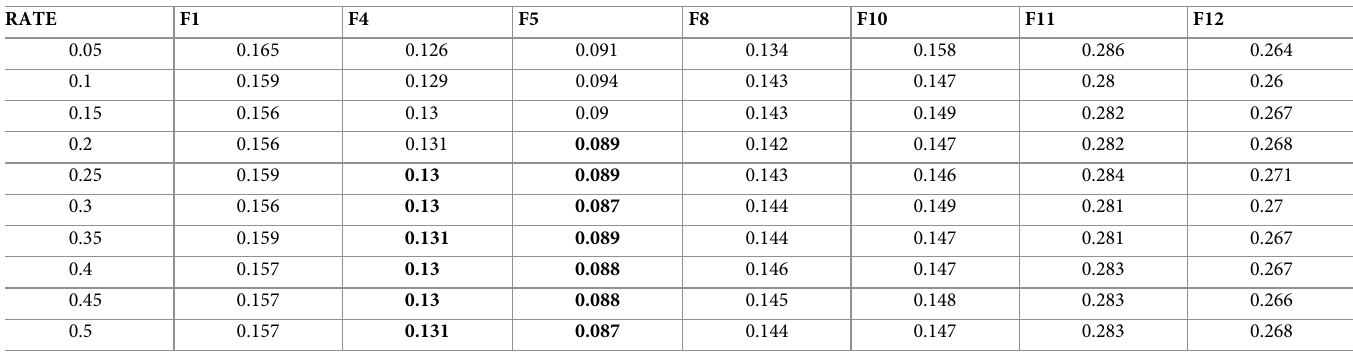
Table 16. MAE of mode replacement by feature.